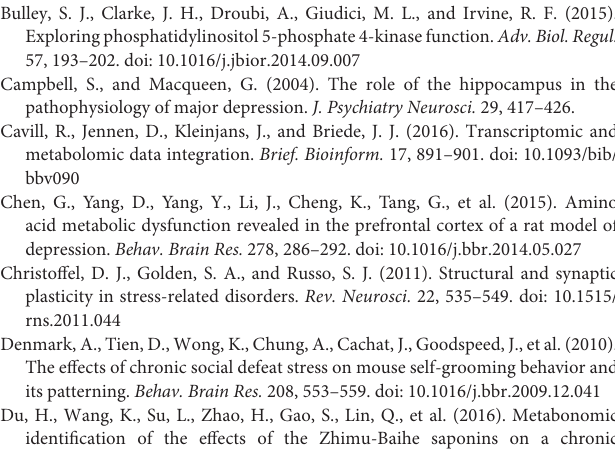
FIGURE S1 | Results of Behavioral tests. (A) Body weight change between CSDS group ( n = 9) and CON group ( n = 8). (B) Sucrose preference changes between CSDS and CON groups. (C) Immobility time in the forced swim test. (D–F) Total distance, time spent in the inner squares, and rearing frequency in the open field test, respectively. (G–J) Open arms time, closed arms time, number of open arms entries, and number of closed arms entries in the elevated plus-maze, respectively. ∗ P < 0.05. TABLE S1 | Identified differential metabolites in the hippocampus between the CSDS and CON groups. TABLE S2 | Identified differential proteins in hippocampus between the CSDS and CON groups. TABLE S3 | Top ten canonical pathways by IPA analysis of integrated data from proteomics and